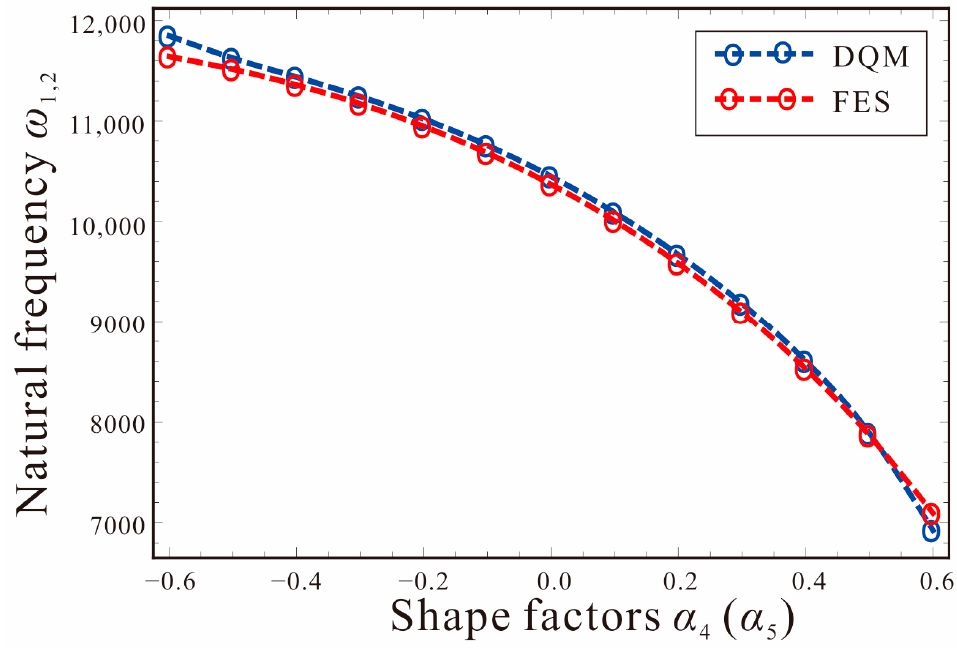
Figure 7. Comparison of the first two orders natural frequencies of the tapered beam between DQM and FES.